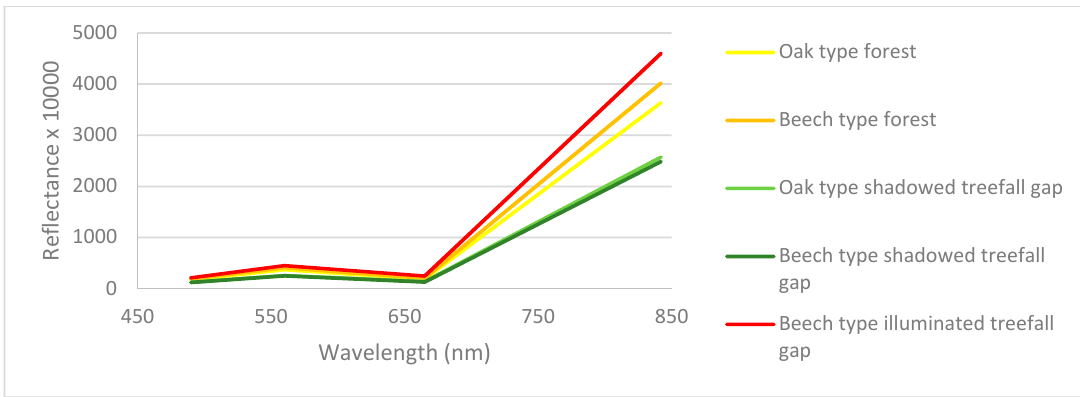
Figure 8. Endmembers spectral profile from one illumination class.